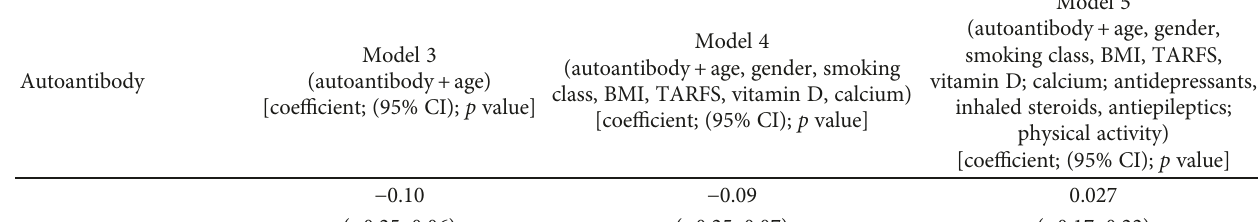
Table 8: Correlation between autoantibodies and quantitative ultrasound index (QUS index) after adjustment for potential